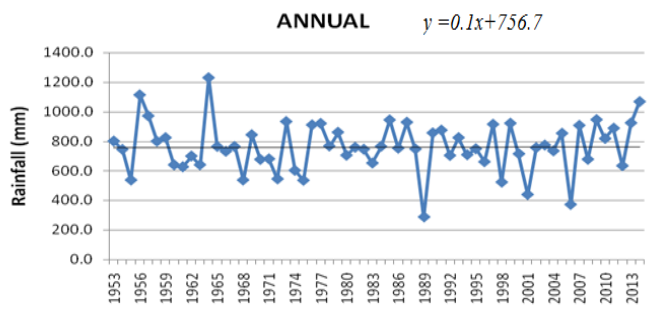
Figure 4. The time series of the annual rainfall.